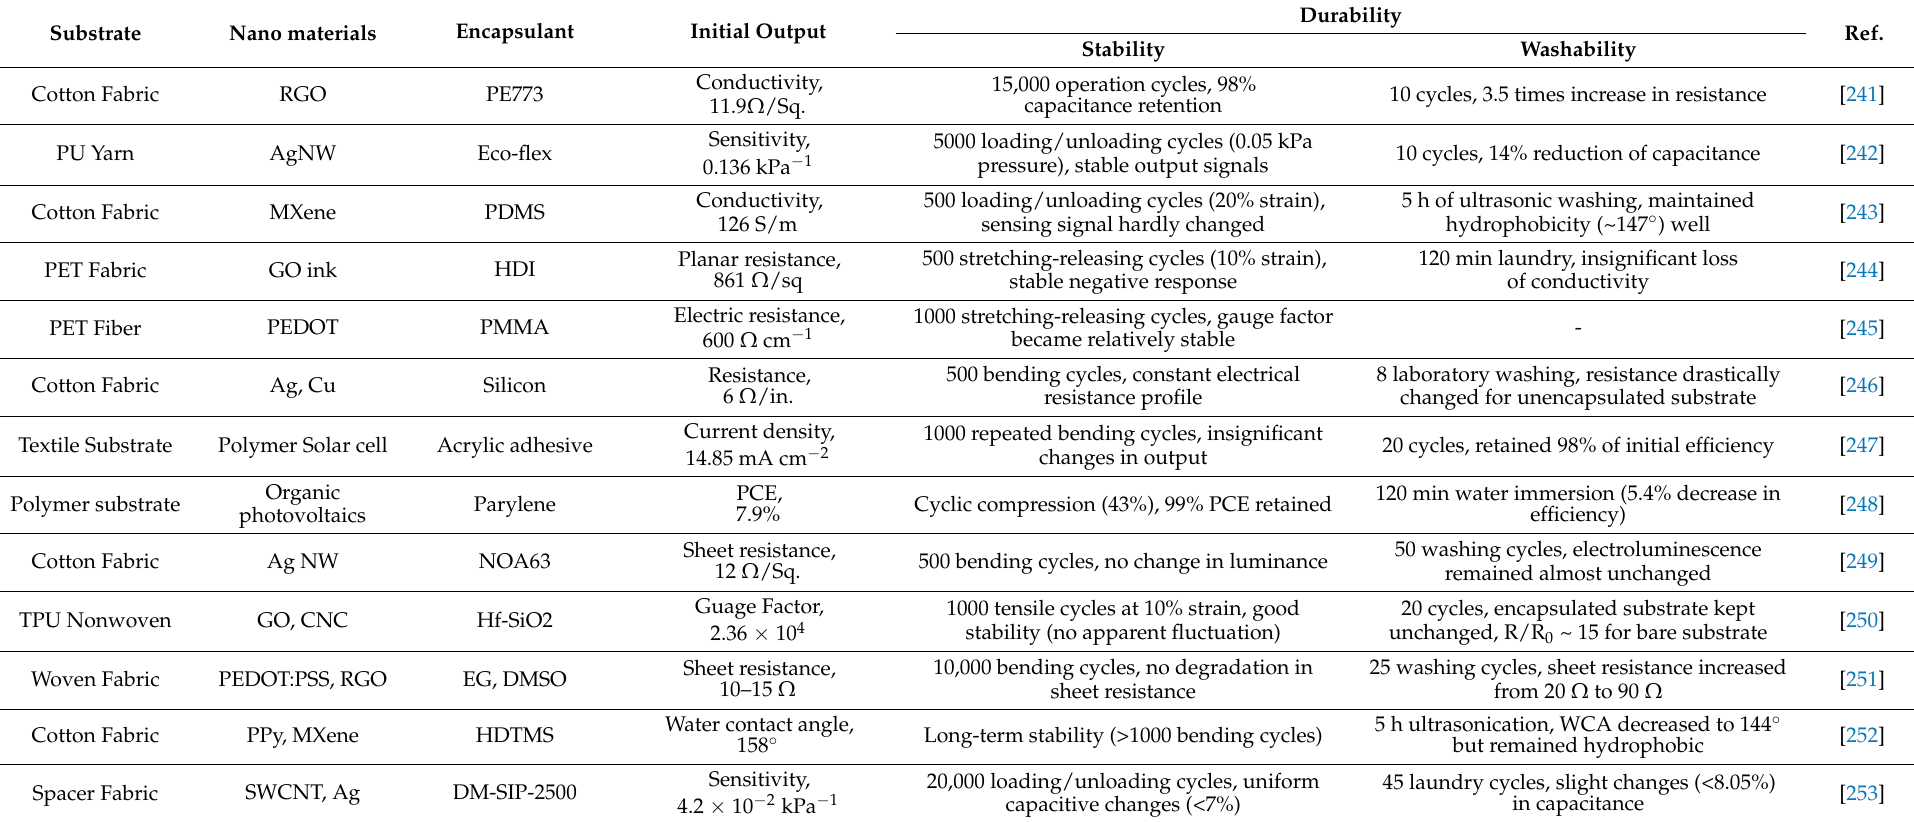
Table 4. Durability enhancement of e-textiles through different encapsulation